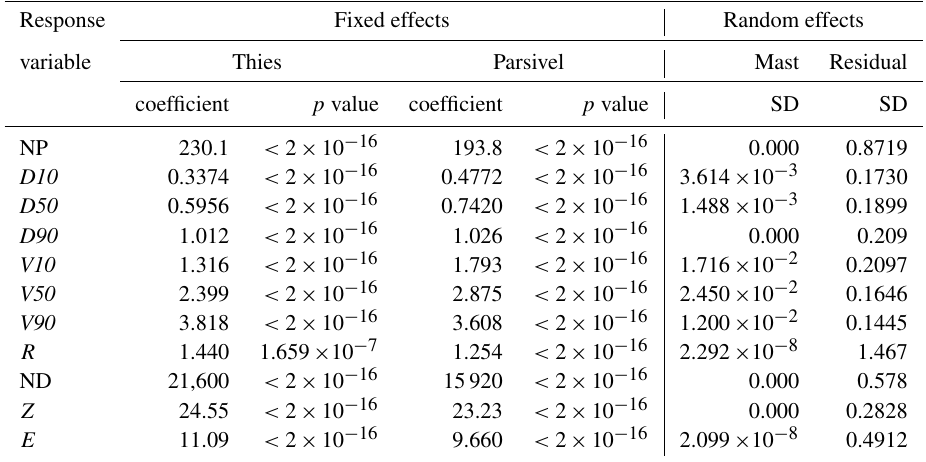
Figure 7. Kernel density plots for 1min records. Table 4. Gamma generalized linear mixed-effects model coefficients for 1min records (random sample size of N = 1000). Refer to Table 2 for a list of acronyms of response